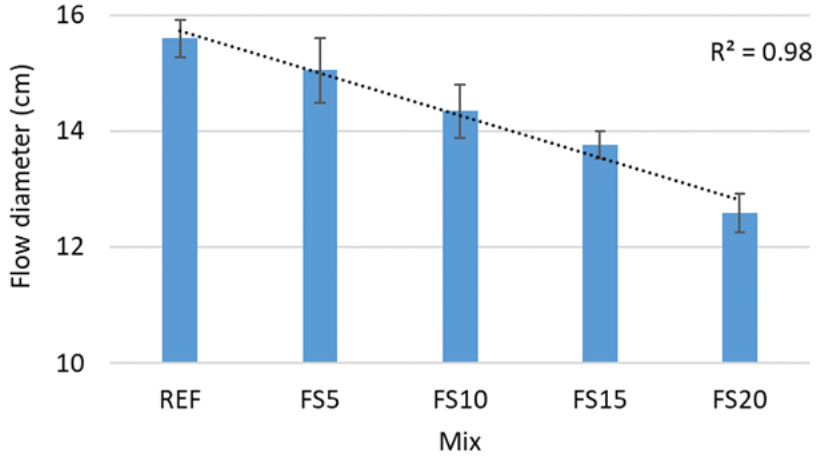
Figure 8. Variation of flow diameter with the addition of flash-calcined sediment.